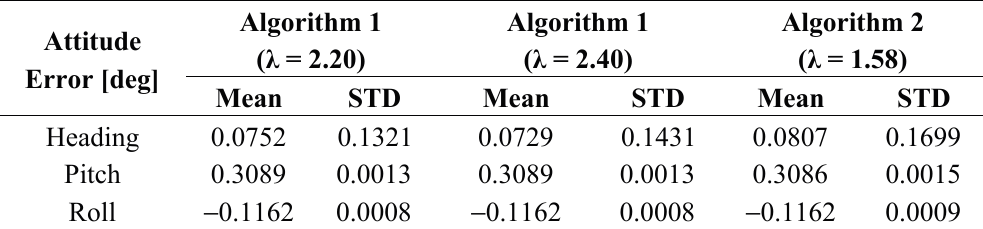
Table 15. Statistics for the results of the sea